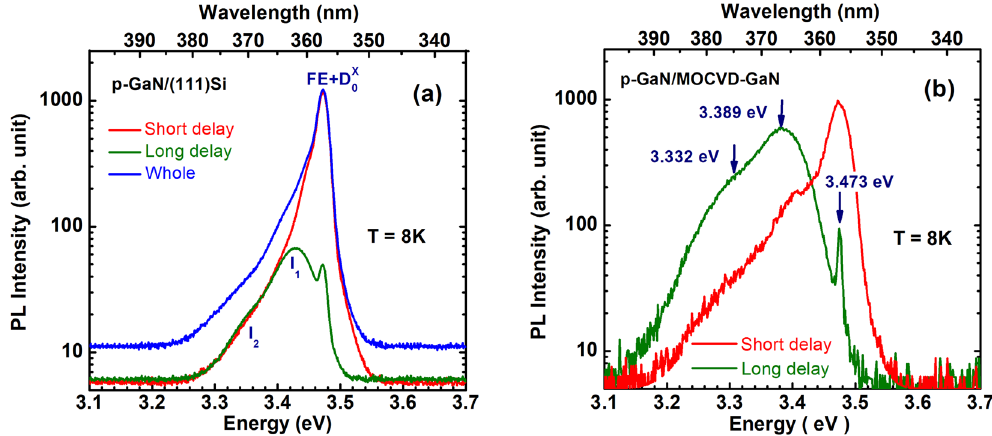
Figure 2. Time-integrations of time-resolved PL spectra collected at low temperature from the two porous GaN samples (a ) p-GaN/(111)Si and (b) p-GaN/MOCVD-GaN measured using 300 grooves/mm grating. Restricting the integration to long delays after the laser excitation pulse permits is to clearly reveal the existence of stacking faults leading to I 1 (3.42 eV) and I 2 (3.35 eV) related recombinations. In the high energy range the PL is due to confined free (FE) and donor-bound (D 0 X) excitons recombination.